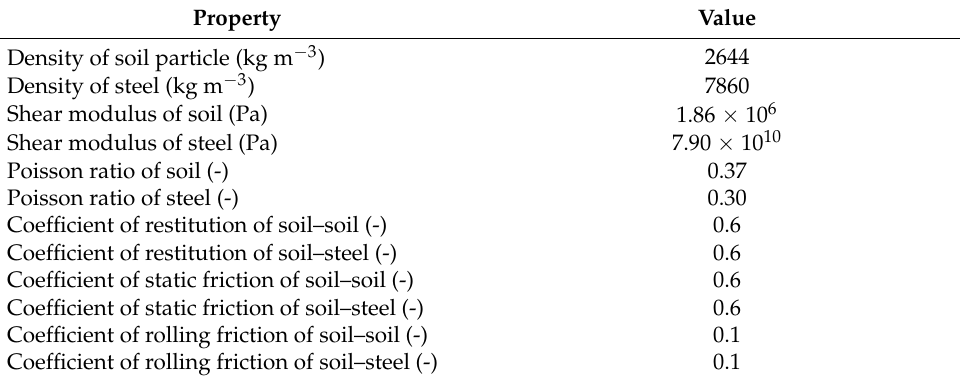
Table 2. DEM input parameters used in the simulations.